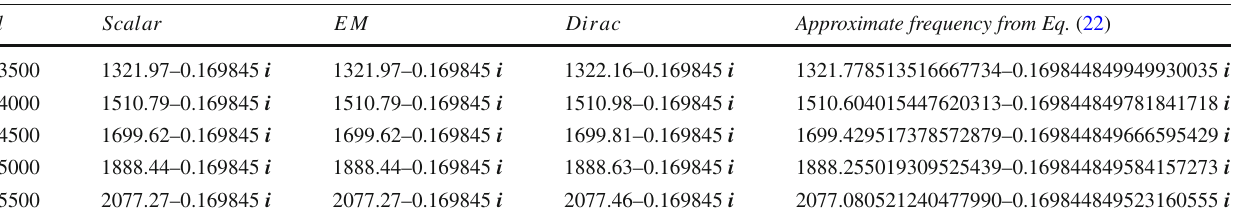
Table 3 The table shows the quasinormal frequencies for the n = 0 mode and for very large multipole numbers l for a four dimensional Gauss– Bonnet de Sitter black hole with M = 0 . 5, α = 0 . 2 and (cid:3) = 0 . 05 Scalar EM Dirac Approximate frequency from Eq.